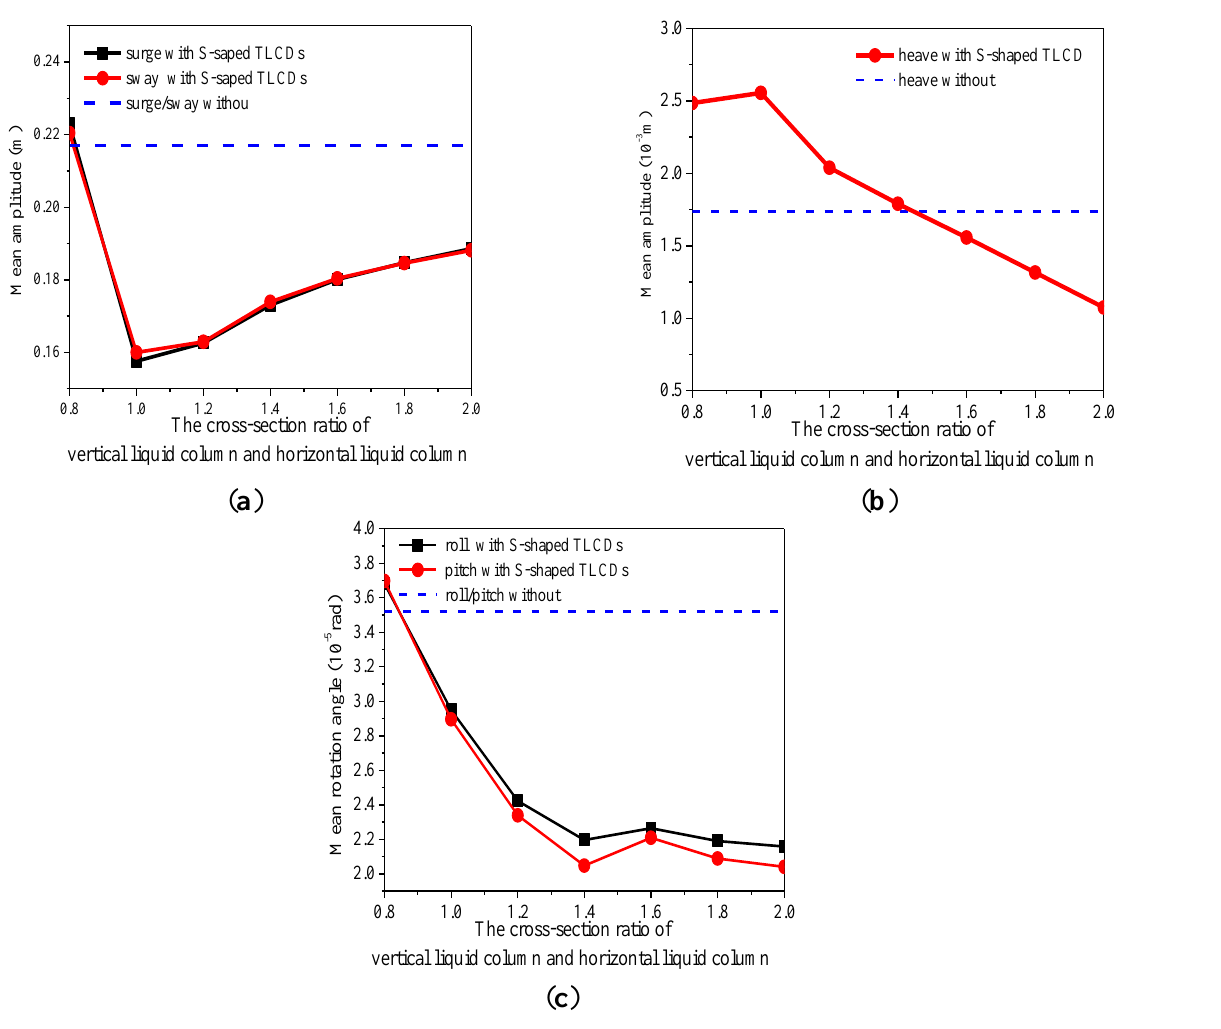
Figure 7. Comparison of responses for x 5 for ( a ) surge, sway; ( b ) heave; ( c ) roll, pitch.